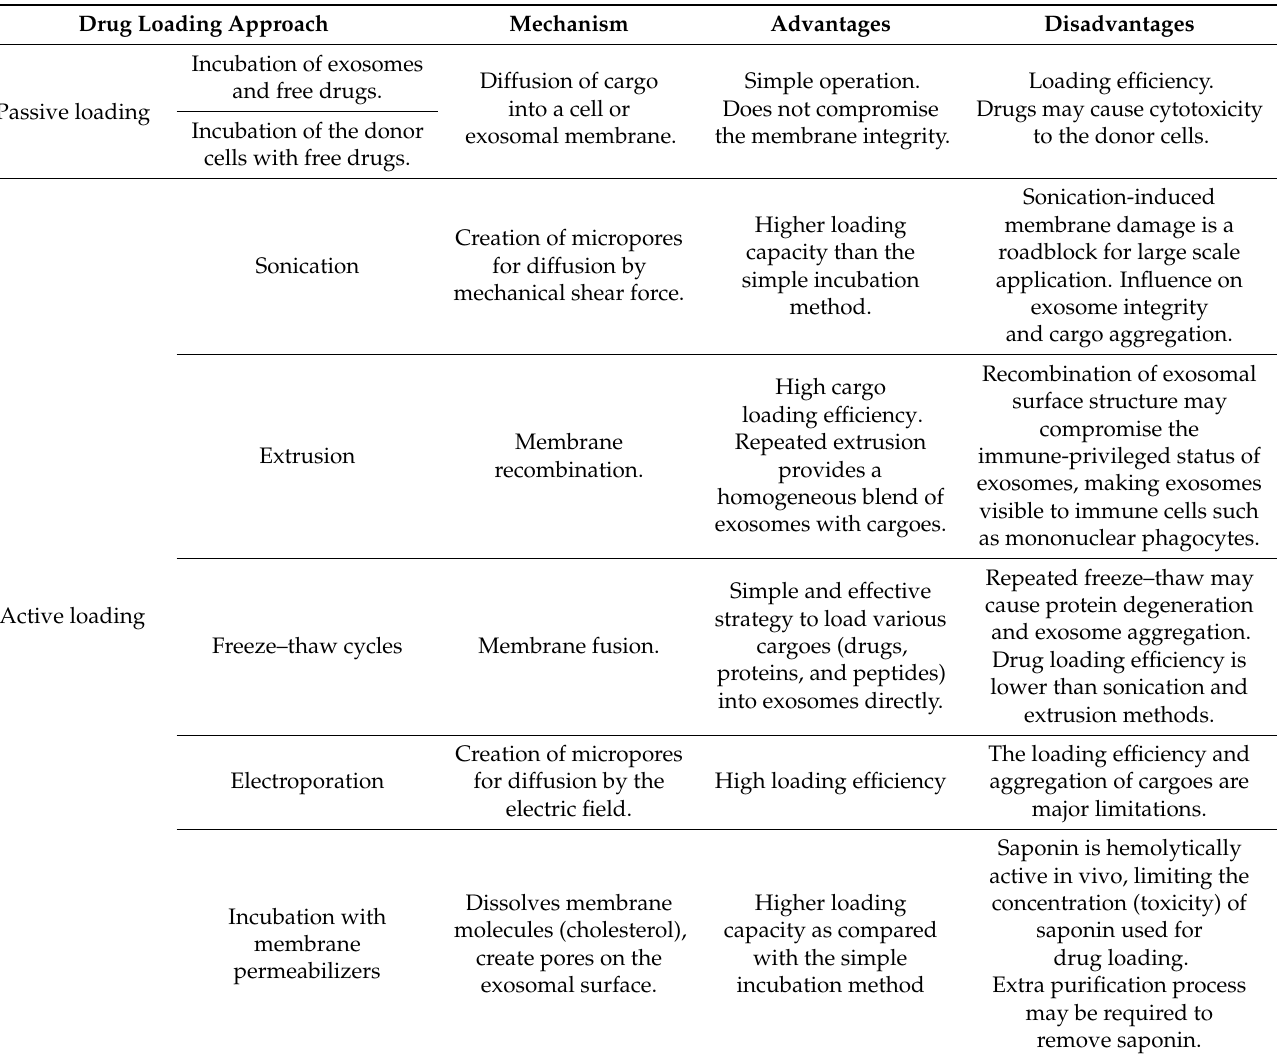
Table 3. Advantages and disadvantages of different exosome drug loading approaches